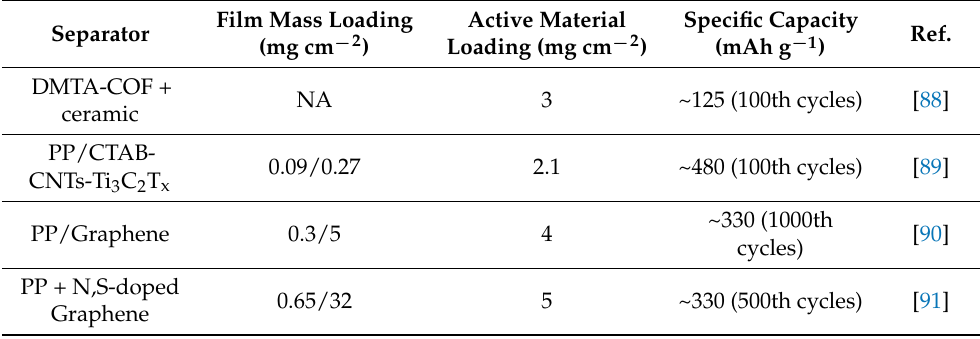
Table 2. Some separators/interlayers designed to immobilize polyselenides and their performance